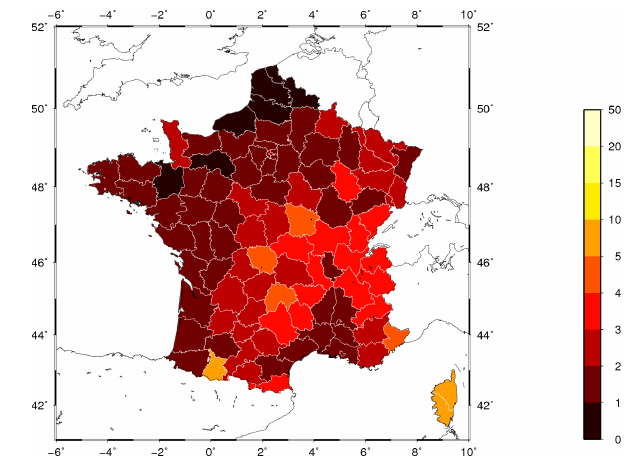
Figure 4. Rank of summer 2018 minimum temperature anomaly per county.